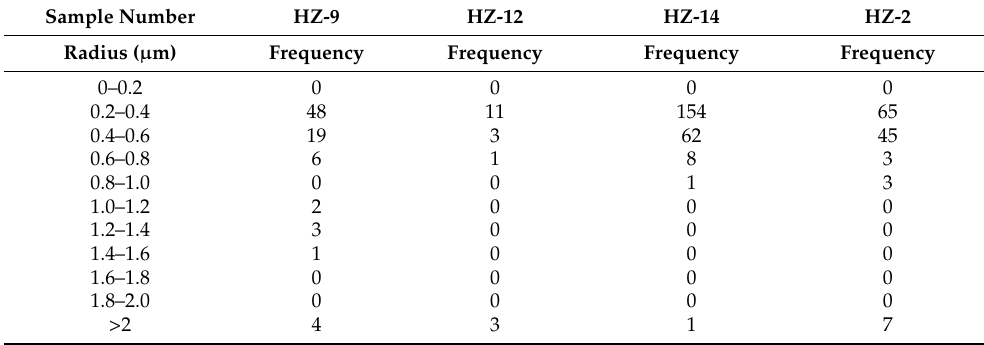
Table 2. Test results of the pore throat radius of the carbonate rock samples from the Huize lead–zinc